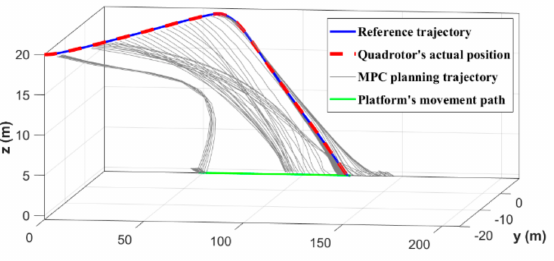
Figure 5. 3D landing trajectory of the quadrotor when the target platform moves along a straight